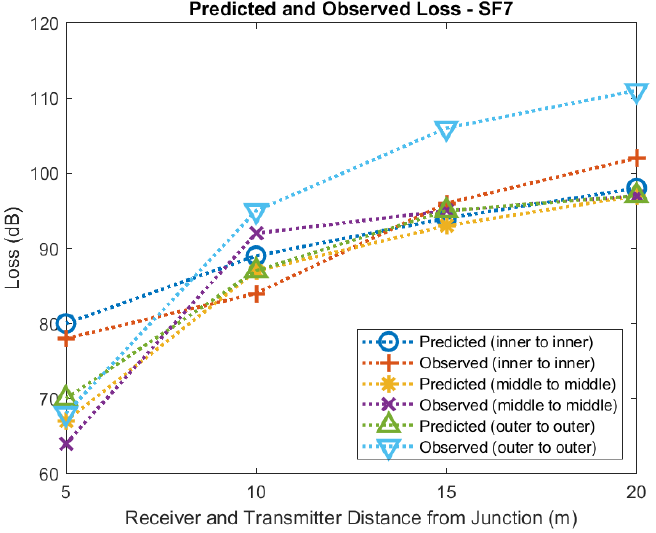
Figure 21. Diffraction modelling of predicted and observed loss at tunnel junction (SF7).